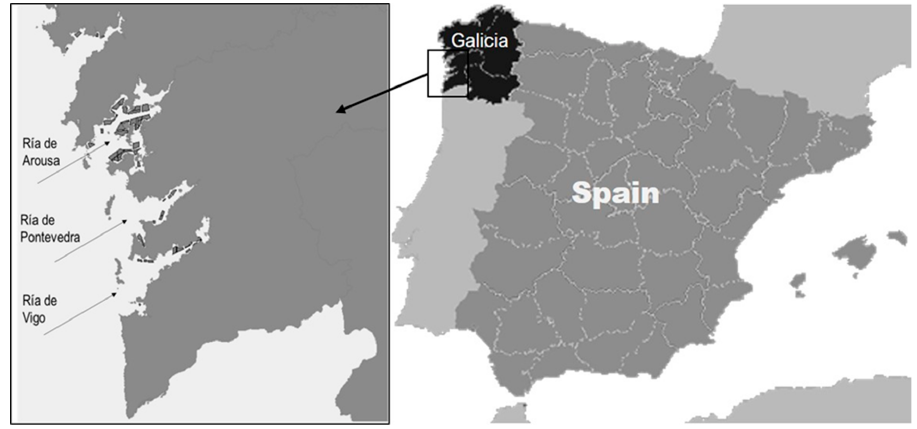
Figure 1. Geographic location of the sampling points considered in the exploratory study.